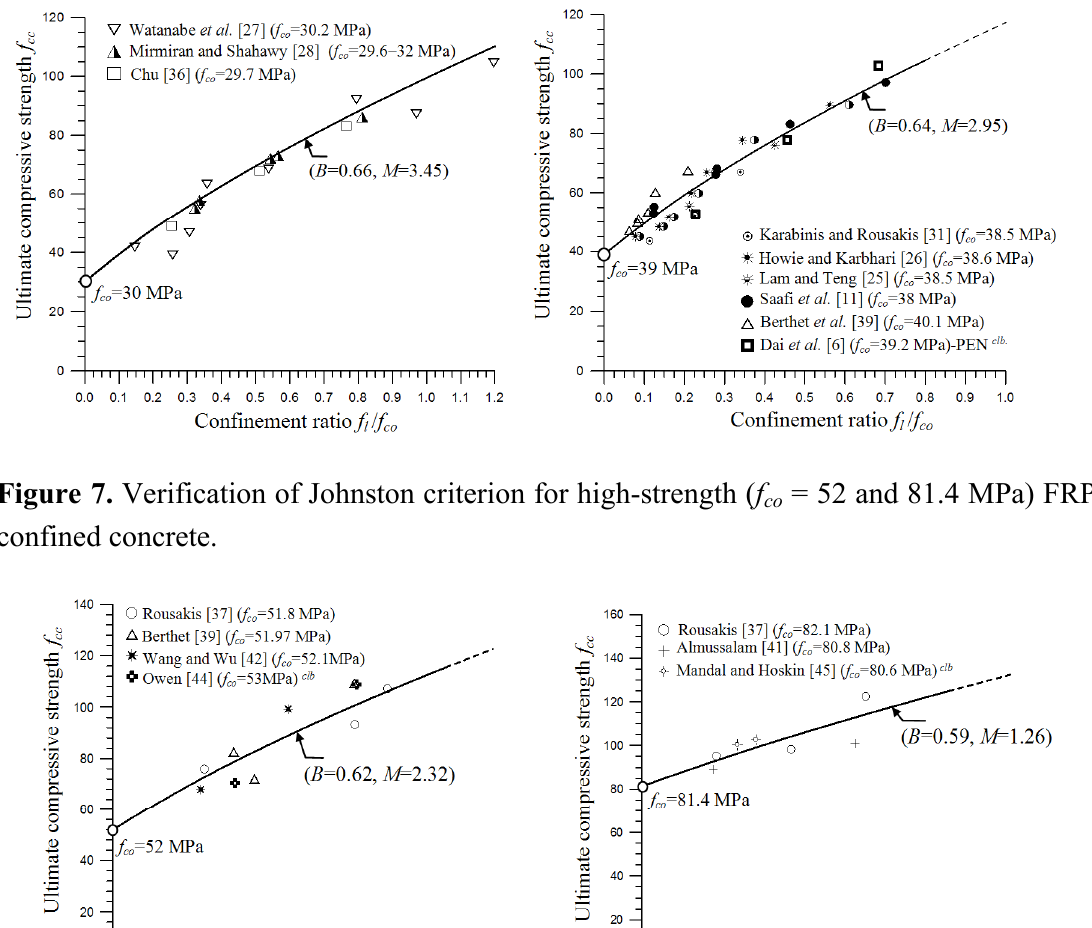
Figure 6. Verification of Johnston criterion for normal-strength ( f confined concrete.